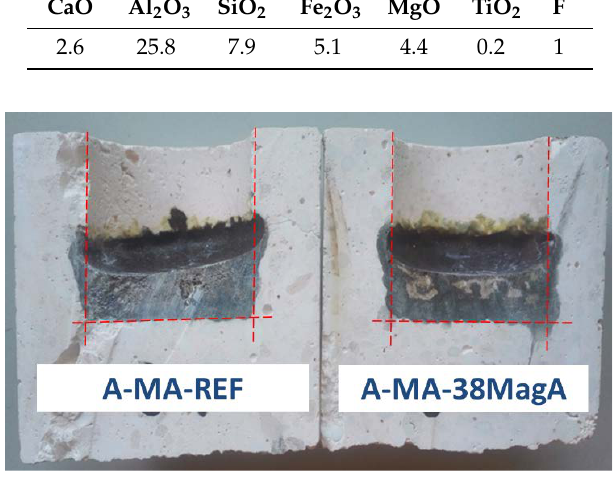
Figure 5. A-MA castables with slag treatment at 1600 °C, 3 h.